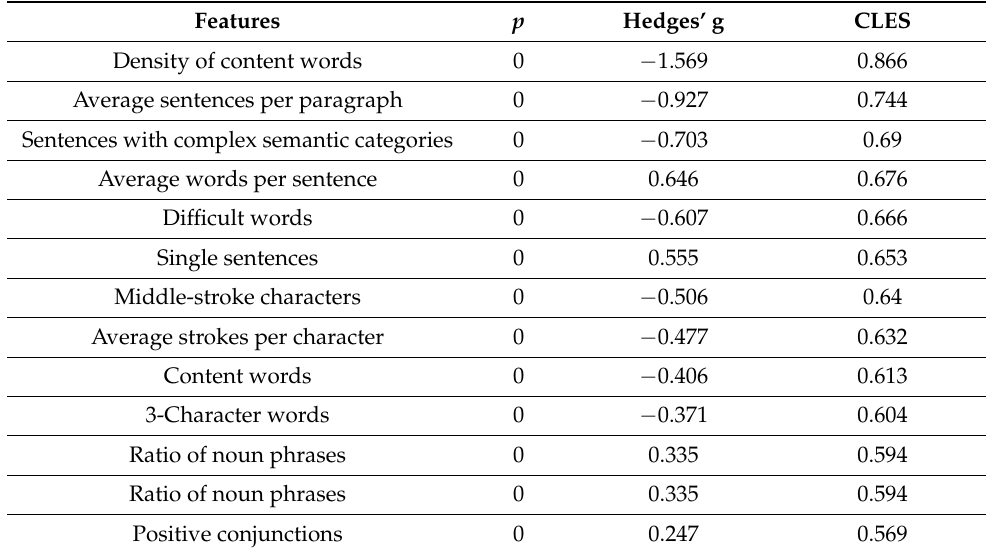
Table 2. Computation of Effect Sizes Hedges’g and Common Language Effect Size (CLES).